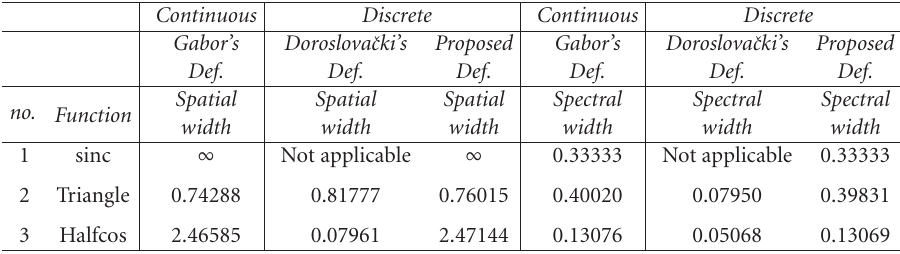
Table 2.1. Comparison of spatial and spectral